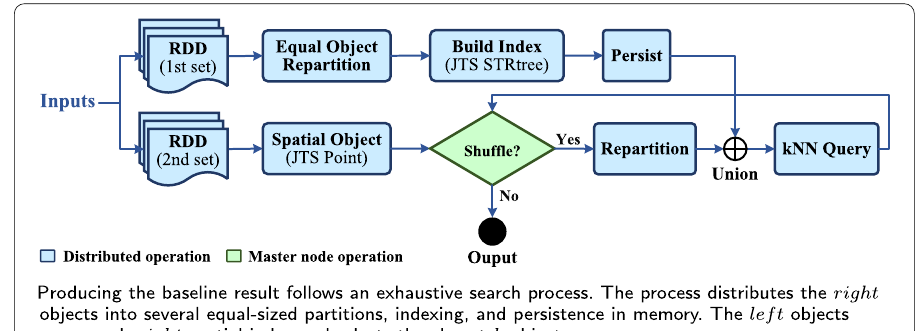
Fig. 12 Workflow for producing the k NN baseline